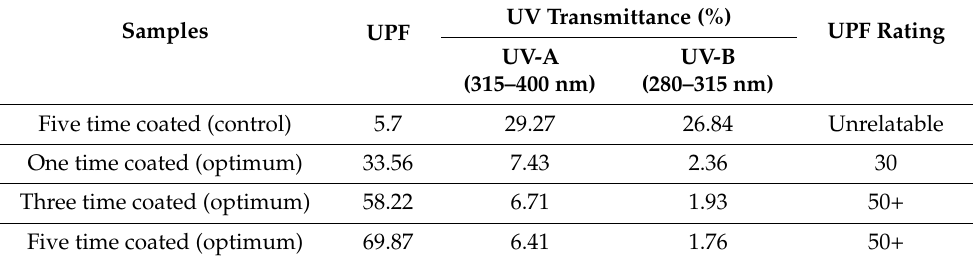
Table 5. Ultraviolet protection factor (UPF), transmission in UVA and UVB region and the UPF rating of the cotton